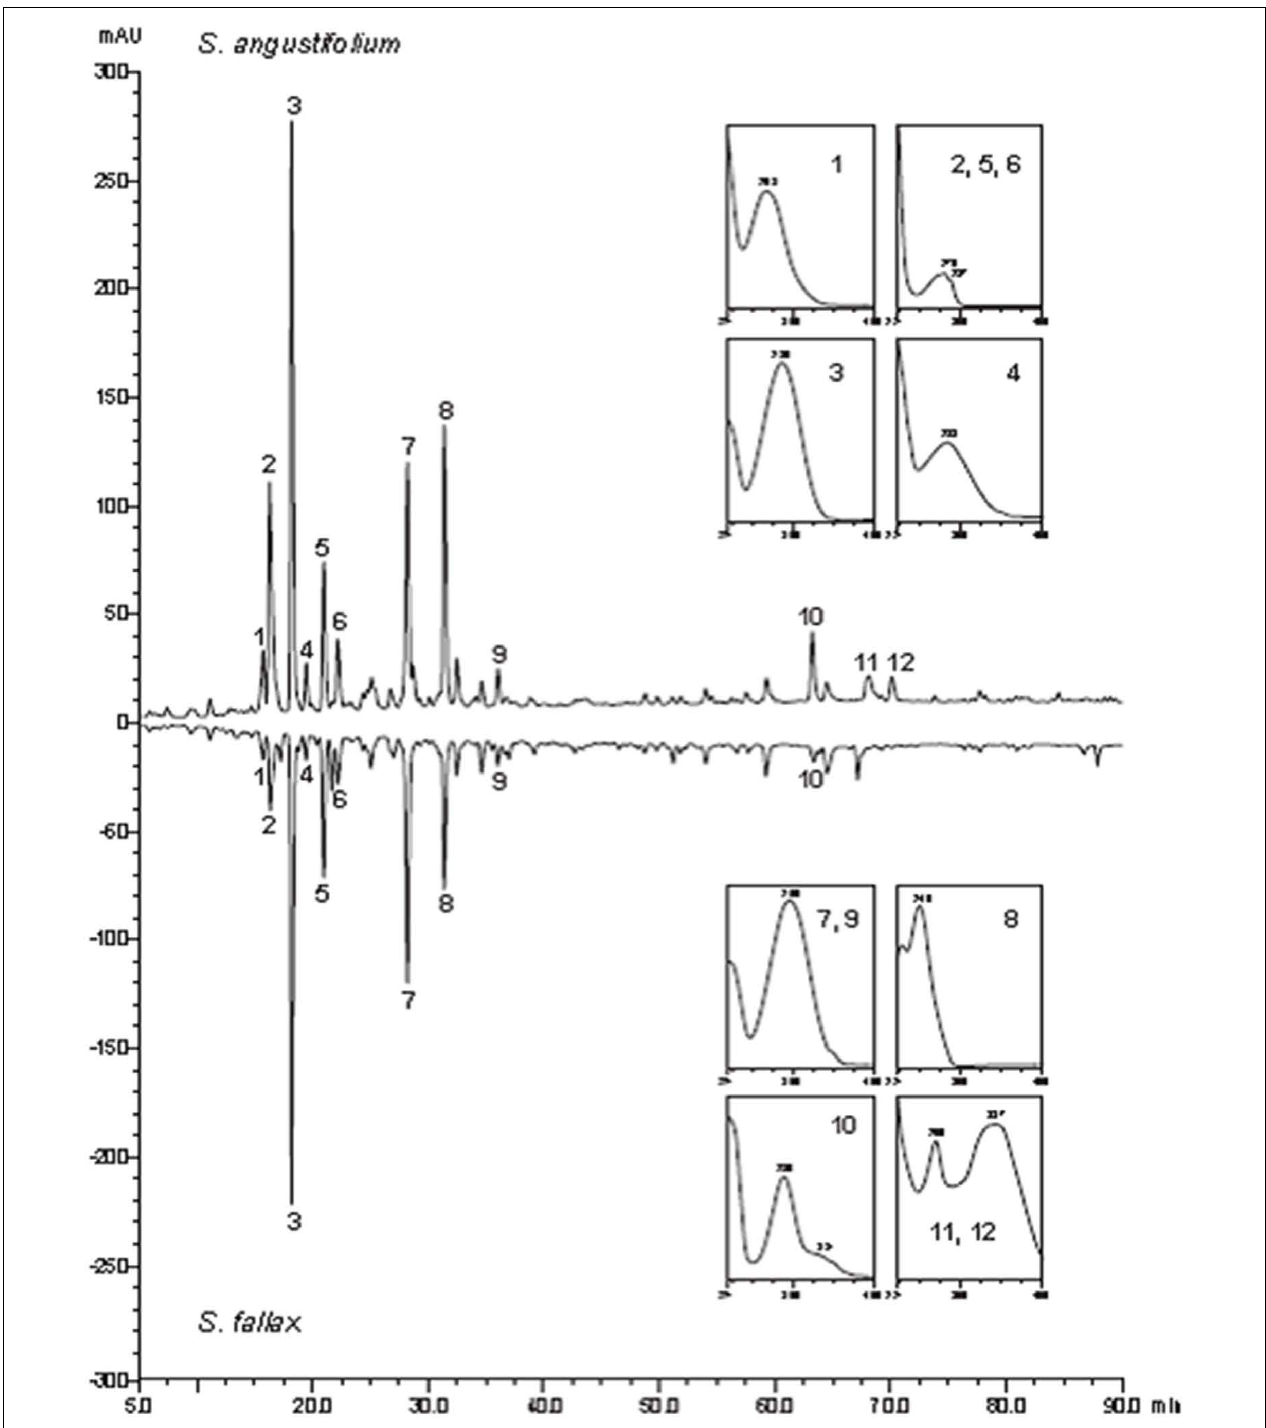
FIGURE 1 | High-performance liquid chromatography -UV secondary metabolite profiles of S. angustifolium and S. fallax at 229nm (UV spectra (200–400nm; 1, phenol; 2, 5, 6, indole derivative; 3, 4, phenols; 7, 9, sphagnic acid; 8, phenol; 10, naringenin type flavonoid; 11, 12, apigenin flavonoids.